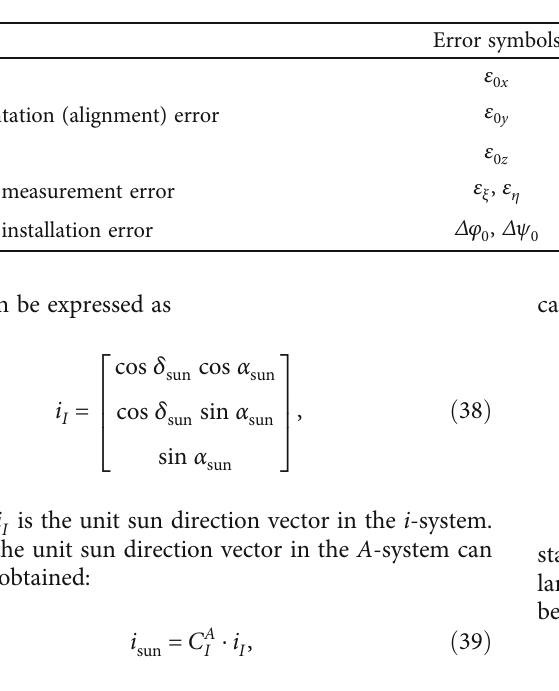
Table 3: The value of each error in the